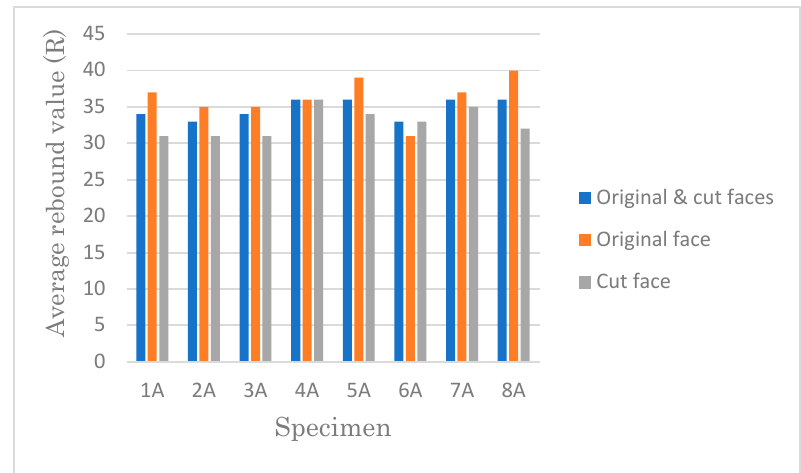
In the case of average rebound value obtained from middle points, the influence of face type is not significant due to the closeness of the results except for specimen 4A (Fig- Figure 6. Average rebound value (R) from all points. Figure 6. Average rebound value (R) from all points. ure 7). In addition, the rebound value calculated from the cut face is less than that of the original face, except at specimen 6A (Figure 6), and one of the possible reasons to have lower results when compared to the original face is surface damage during cutting of the specimen at the microstructure level.